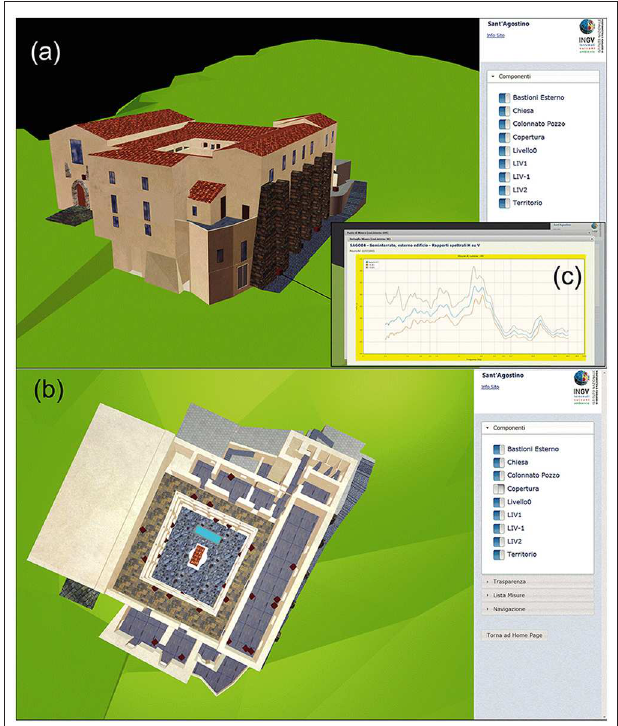
FIGURE 8 | Visual platform at building scale of the MASSIMO system: (a) view of the entire 3D model of the monumental complex of Sant’Agostino and (b) view from top excluding the roofs. The red cubes are the measurement points. (c) HVSR obtained by recording of ambient vibration for a point immediately outside the wall with buttresses.